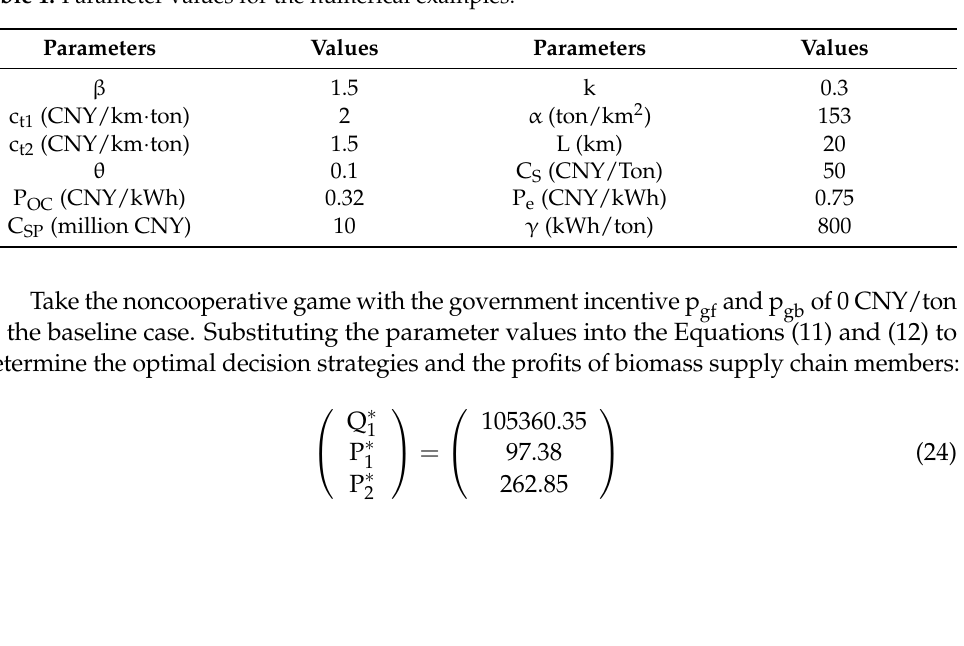
Table 1. Parameter values for the numerical